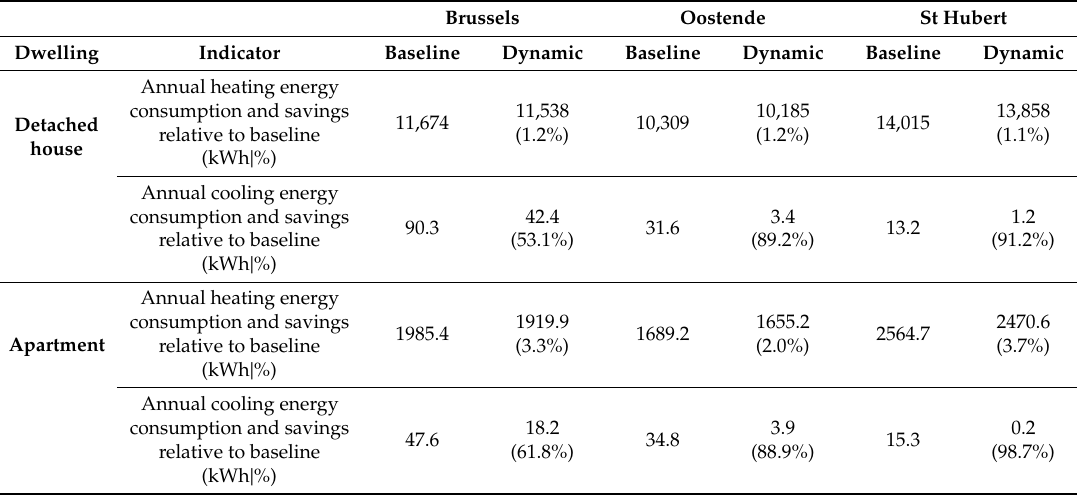
Table 4. Comparison of annual heating and cooling energy consumption for static and dynamic insulated walls applied to the prototypical dwellings for three climates in